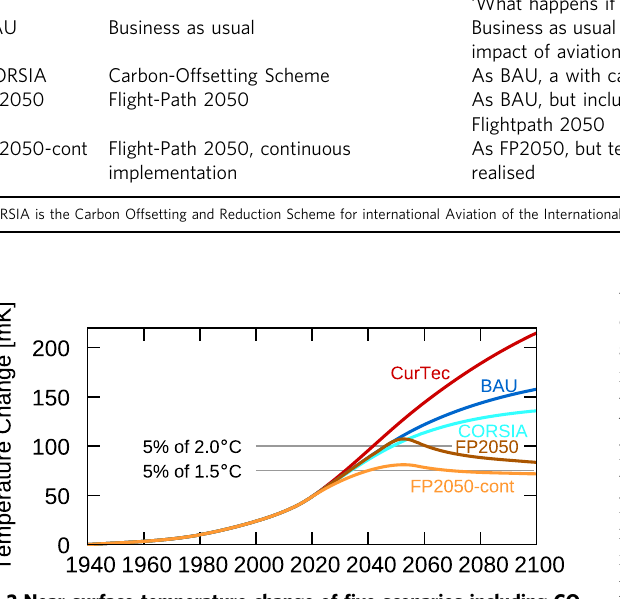
scenarios CurTec (red line), BAU (dark blue line), and CORSIA (light blue line) show an increase in temperature until the end of the simulation (2100), though the rate of increase slows down.